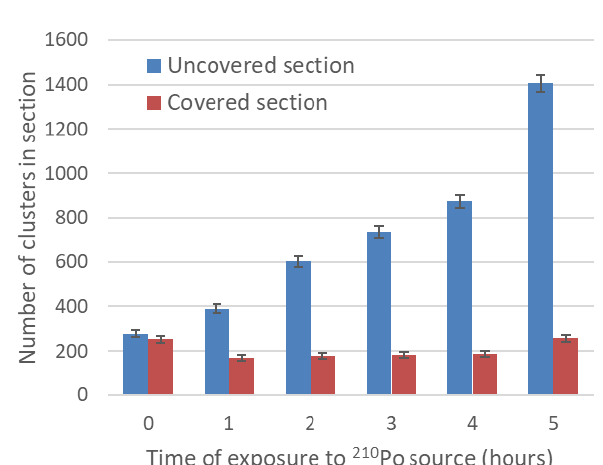
Fig. 4. The number of bright pixels in a 30-s background measurement for equivalent-size sections on the covered and uncovered side of the CCD after each additional hour of exposure to a 210 Po source.